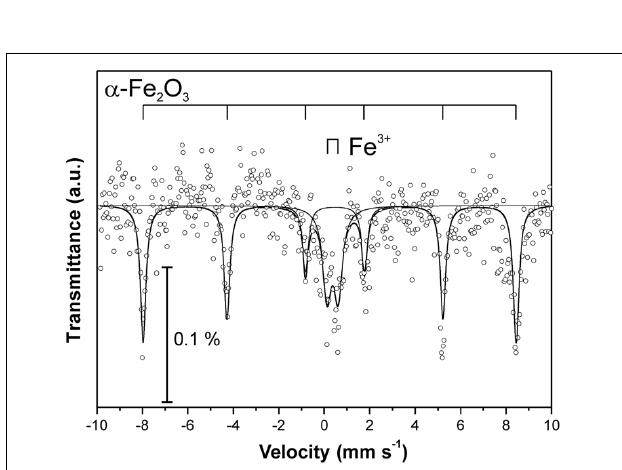
FIGURE 14 | Hematite determined by Mössbauer spectroscopy at Kombat